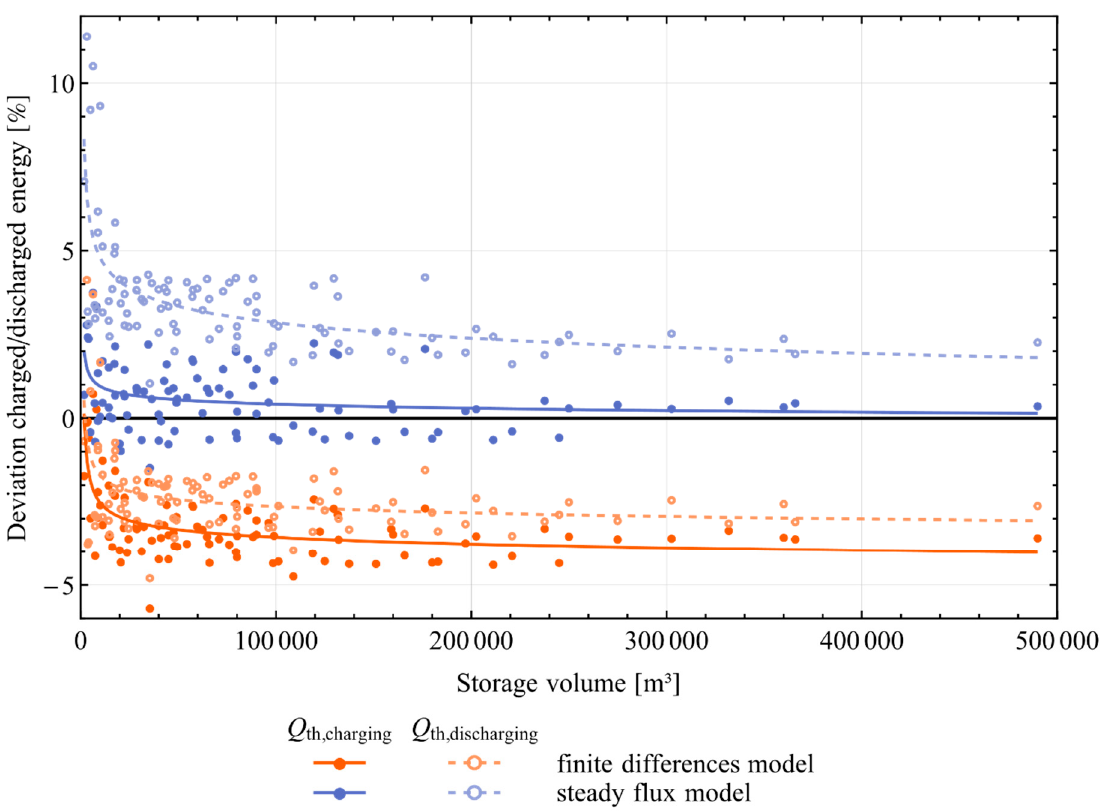
Figure 6. Relative deviation of charged and discharged thermal energy between MoBTES and FEFLOW for different storage system layouts.